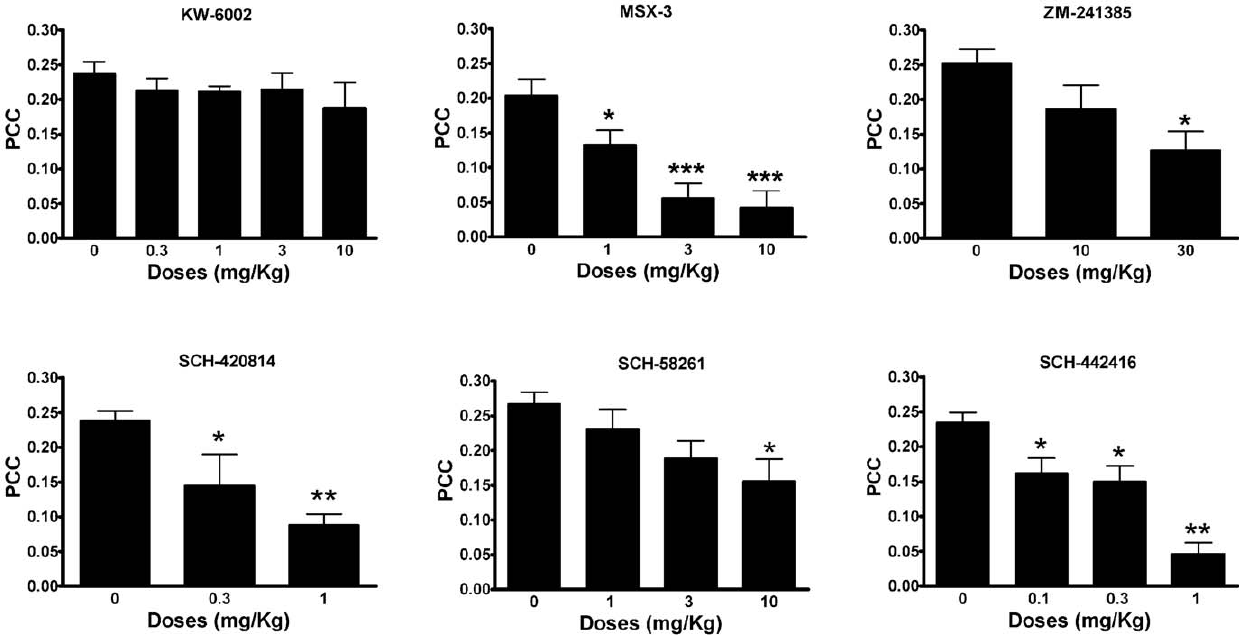
Figure 2. Blockade by A 2A R antagonists of the motor output induced by cortical electrical stimulation. Dose-dependent decrease in the Power Correlation Coefficient (PCC) induced by the administration of different A 2A R antagonists. Results represent means 6 S.E.M. (n=5–6 per group). * and **: p , 0.05 and p , 0.01, respectively in comparison to vehicle-treated animals (0 mg/kg); ANOVA with post-hoc Dunnett’ comparisons, p , 0.5 and p , 0.01, respectively).